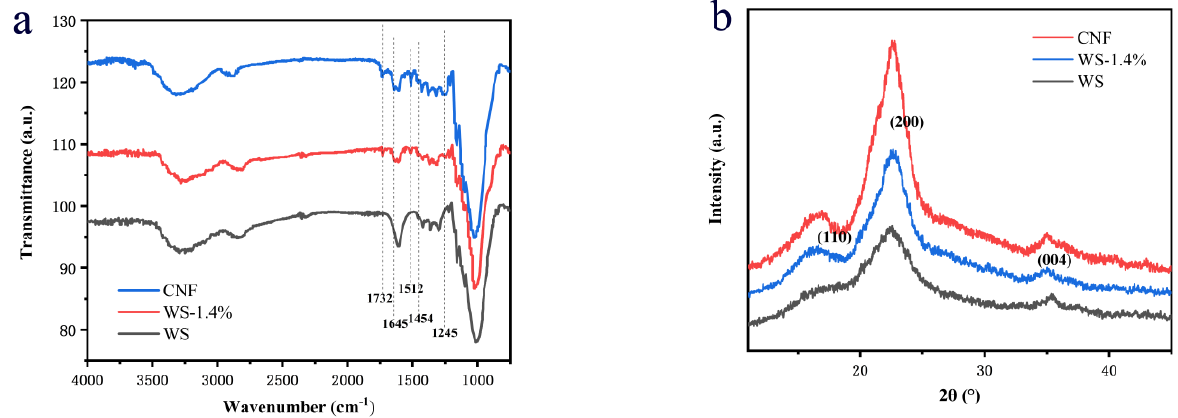
Figure 2. ( a ) FT-IR results of pristine pre-processed WS, WS-1.4% and CNF; ( b ) 1D SR-WAXS integral curve.